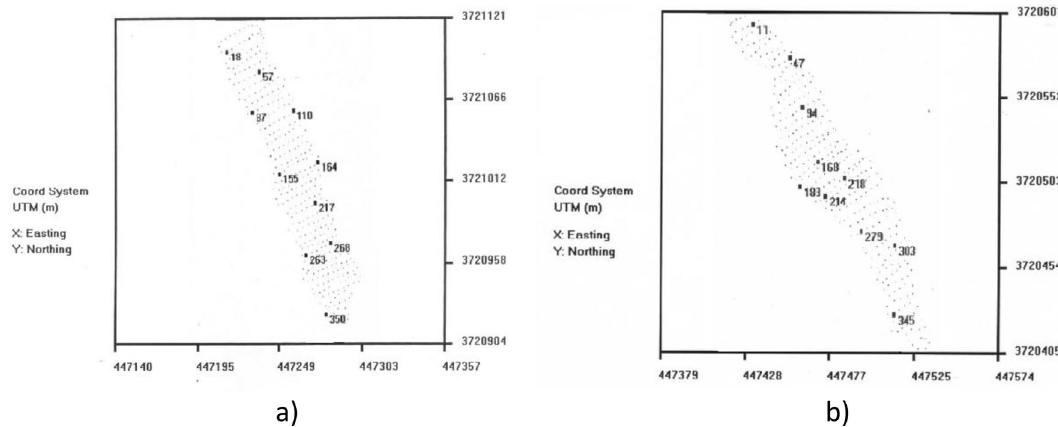
Figure 4. Soil Sampling design for ( a ) fairway 16 and ( b ) fairway 12 created via ESAP